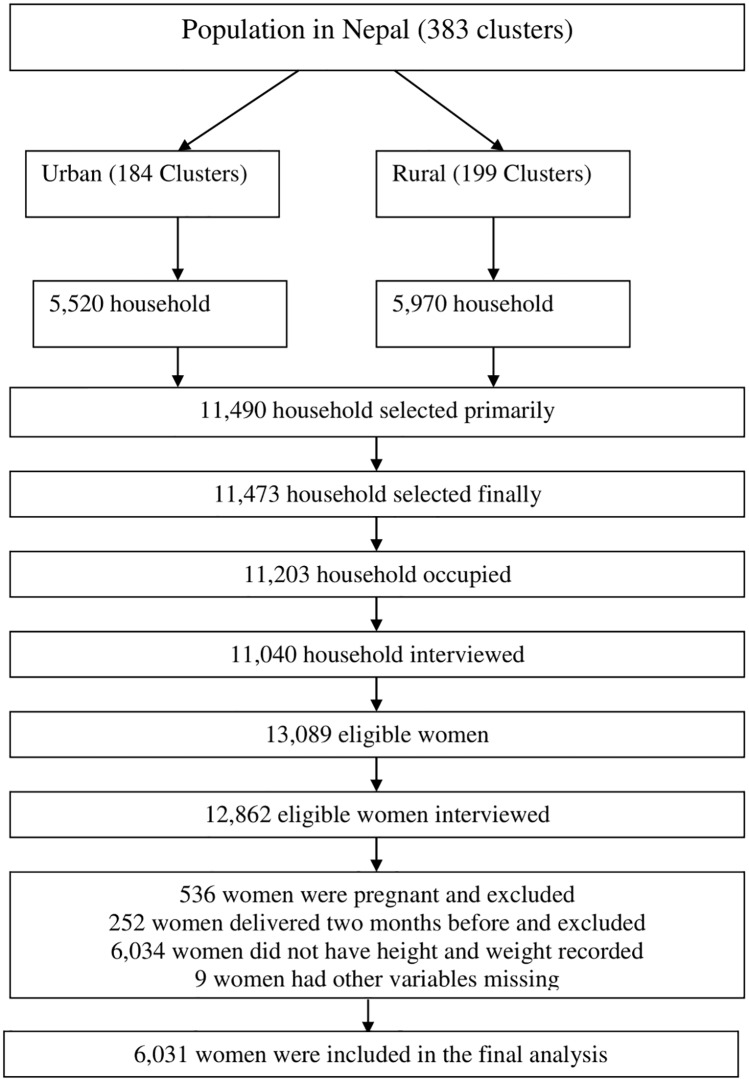
Steps of sample selection in the final analysis.